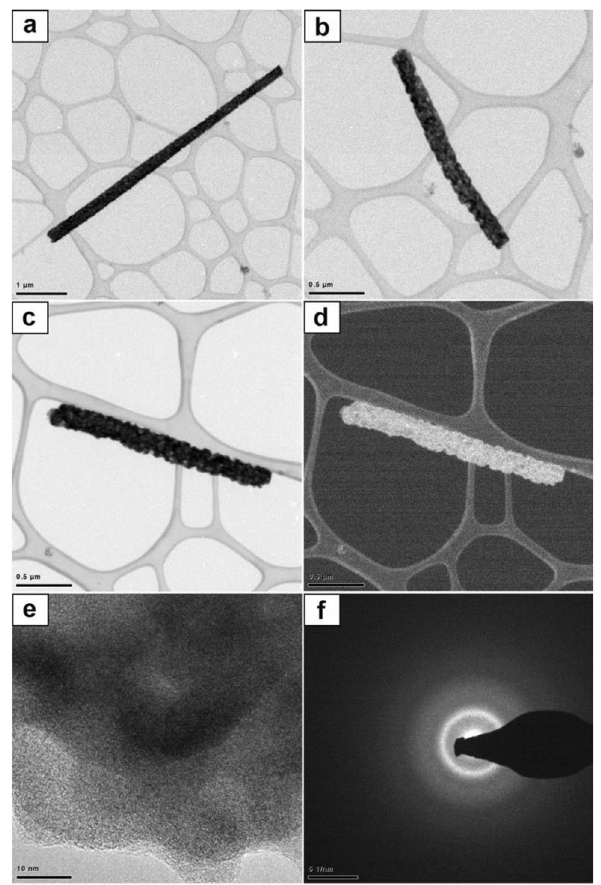
Figure 2. TEM images of the obtained one-dimensional bismuth oxide nanostructures produced by calcination of fibrous composite PAN/Bi 2 O 3 mats at 600 °C made in transmission bronzing ( a ), ( b ), scanning-transmission mode, using bright (BF) and dark field (DF) ( c ), ( d ), HAADF detector ( e ) and using analytical microscopy in nano areas in the STEM mode ( f